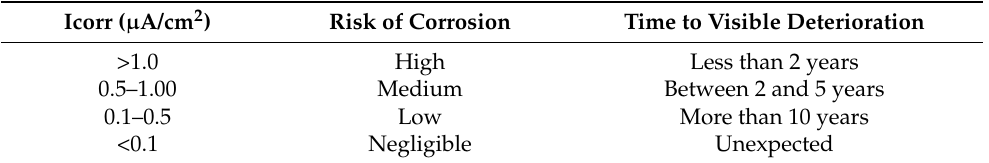
Table 5. Ranges of corrosion current values related to the significance in terms of service life of the reinforcement [37].